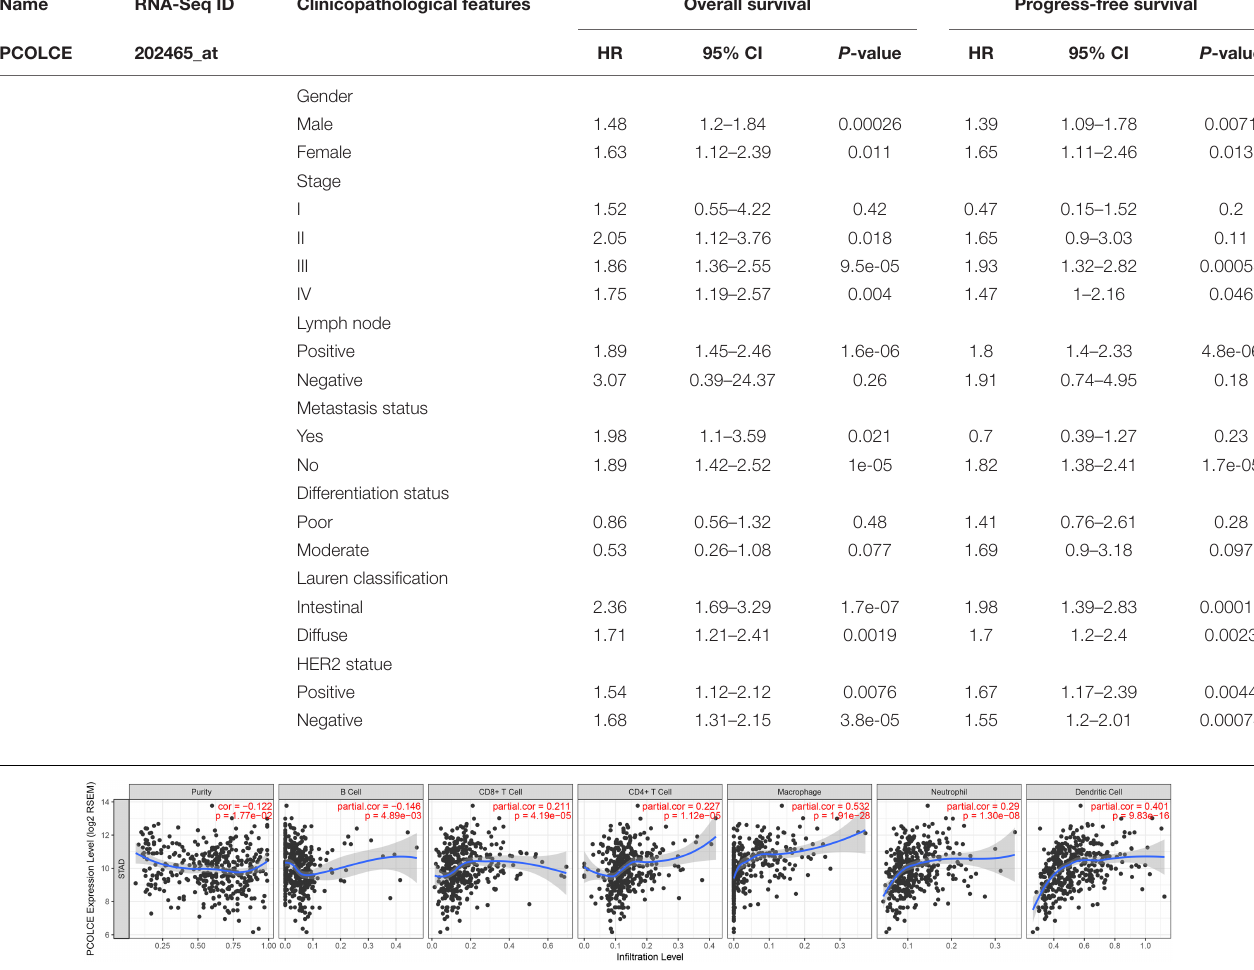
FIGURE 3 | Correlation of PCOLCE expression with immune infiltration level in STAD (stomach adenocarcinoma). PCOLCE expression is significant positive correlations with infiltrating levels of CD8 + T cells, CD4 + T cells, macrophages, neutrophils, and dendritic cells in STAD (stomach adenocarcinoma). While PCOLCE expression has no significant correlations with tumor